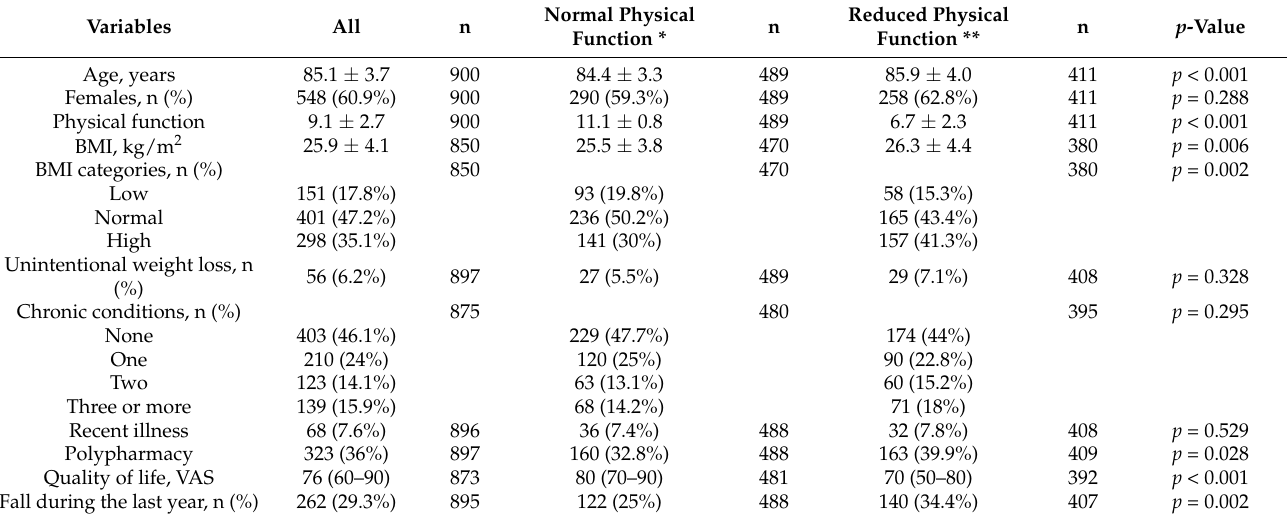
Table 1. Characteristics of study population.